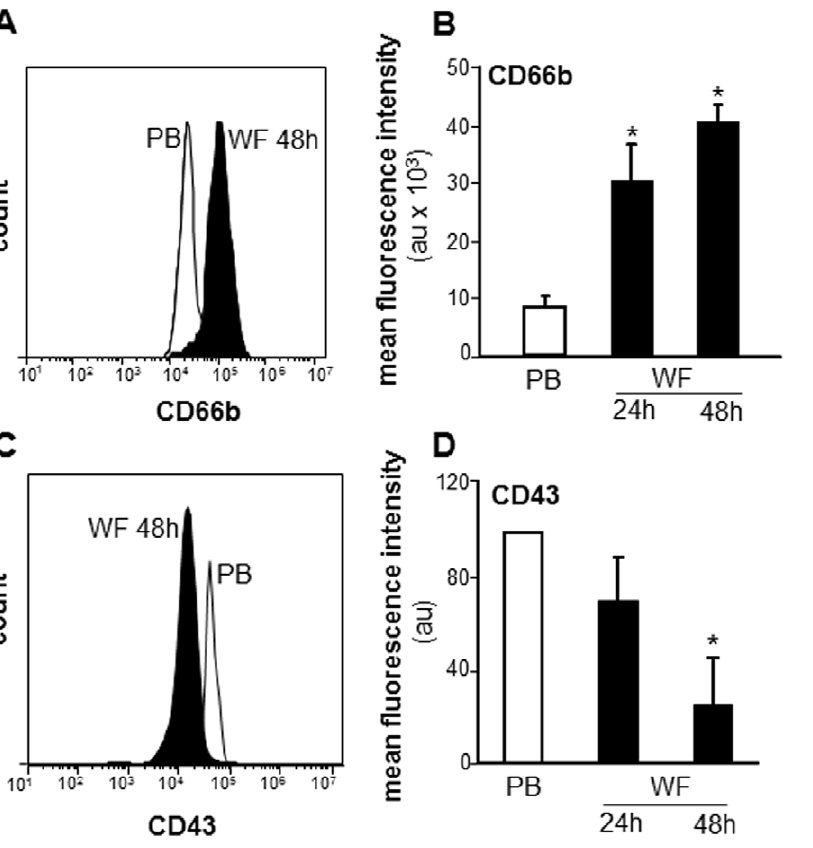
Figure 4. Cells from WF show activated PMN phenotype: increased CD66b and decreased CD43 expression. The WF and PB cells were subjected to flow cytometry analysis following immunostaining with CD66b or CD43. A&C, representative flowcytometry histograms of CD66b and CD43; B&D, quantification of CD66b and CD43 flow cytometry analysis. Data presented as mean 6 SD, n=4. * p , 0.05 compared to PB.